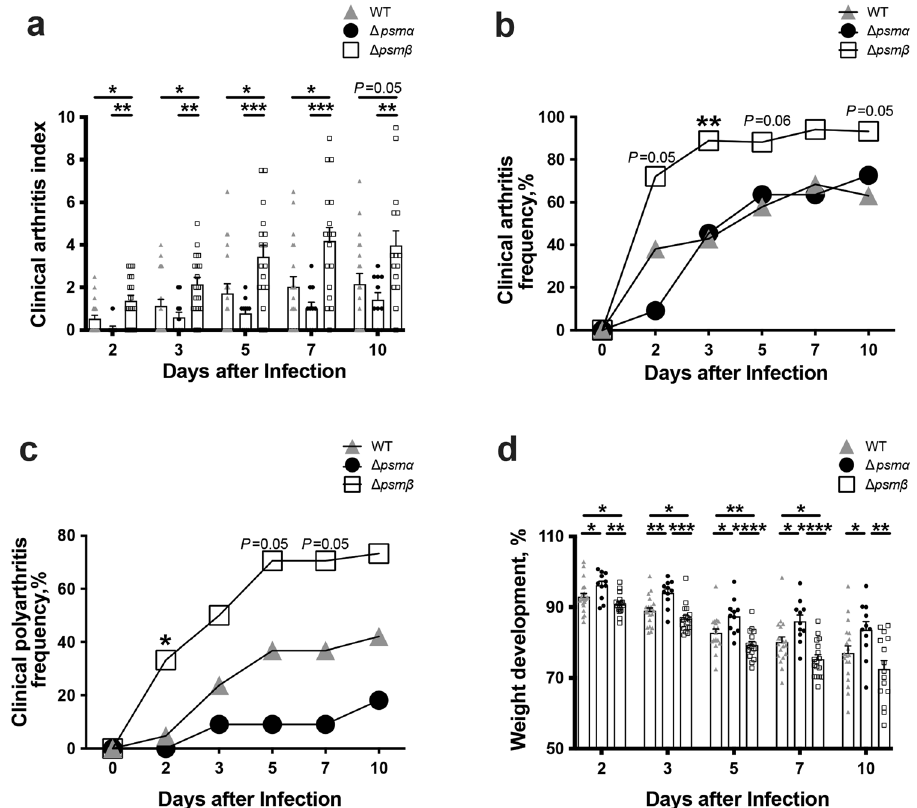
Fig. 4 PSM β de fi cient mutant is hypervirulent in a murine model of septic arthritis. NMRI mice ( n = 11 – 21/group) were intravenously injected with S. aureus Newman (wild type, WT), or the isogenic mutant strains Δ psm α or Δ psm β (5 × 10 6 CFU/mouse) and sacri fi ced on day 10 post-infection. The arthritis severity a , frequency of arthritis b , frequency of polyarthritis c , and the changes in the body weight d were monitored for 10 days post-infection. The results from three independent experiments were pooled. Statistical comparison was performed using the Mann-Whitney U test a , d , and Fisher ’ s exact test b , c . Data are expressed as mean ± standard error of the mean a , d or percentage b , c . * P < 0.05; ** P < 0.01; *** P < 0.001; **** P < 0.0001.